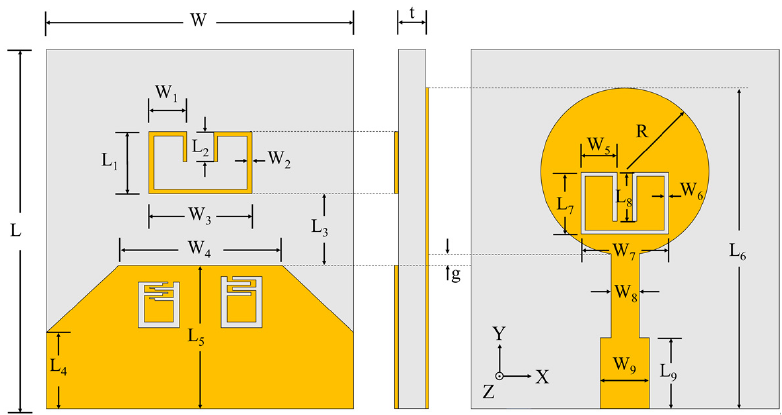
Figure 1. Configuration of the proposed antenna.